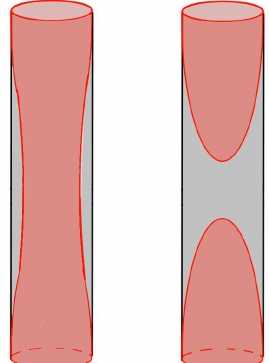
Figure 9. Bulk region associated with CFT 1 (shown in grey) at low and high temperature. As the interface tension approaches the lower critical value, we expect that the transition temperature must be increasingly large in order to admit the high-temperature phase disconnected solution (right) which avoids intersection of the domain